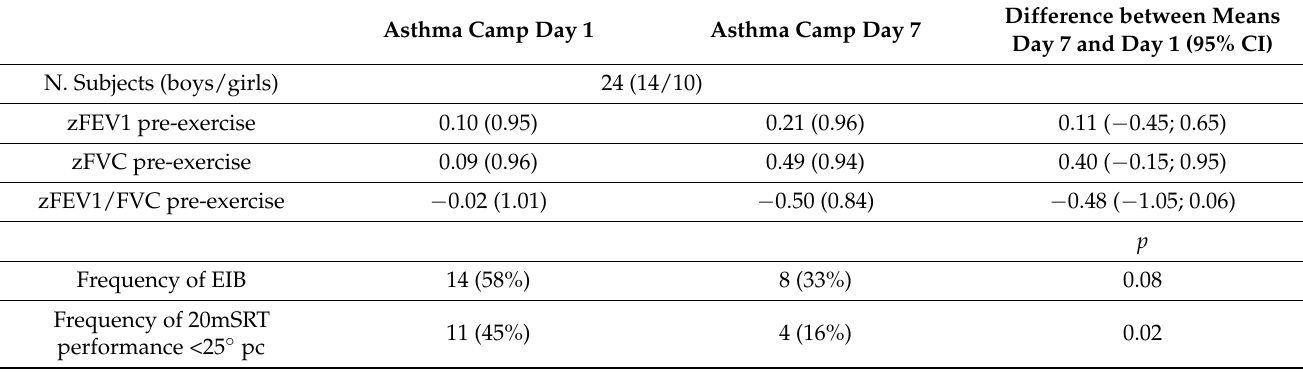
Table 1. Spirometry and 20 m shuttle run test results of asthmatic children participating in a summer camp at moderate altitude (900